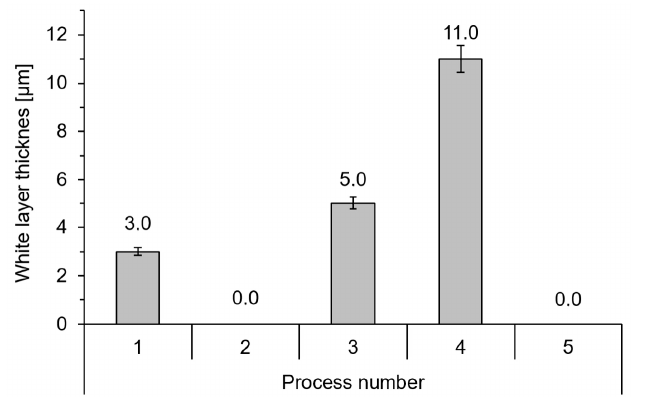
Figure 1. Microstructures of X37CrMoV5 ‐ 1 steel after low ‐ pressure nitriding processes: ( a ) process 2, ( b ) process 3, ( c ) process 4, ( d ) process 5.